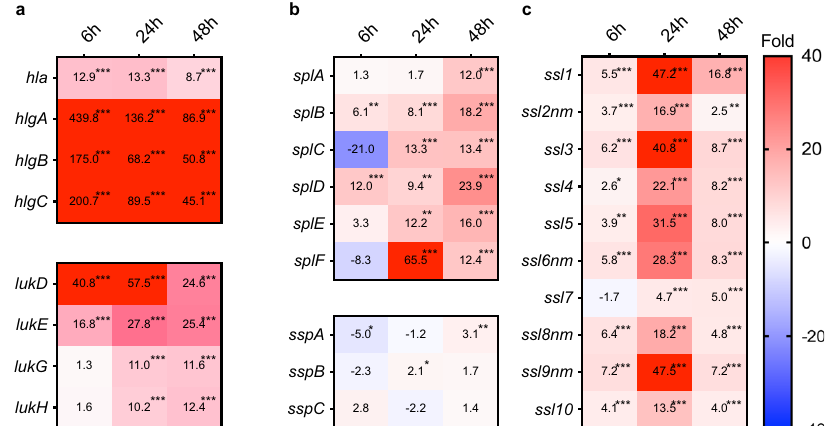
Fig. 5 Time course of expression changes in virulence factors in S. aureus -infected liver compared with culture medium. Time course of expression changes for toxins ( a ), proteases ( b ), and superantigens ( c ). Values in the boxes show fold-change compared with S. aureus cultured in the TSB medium and the boxes fi lled with red indicate >40-fold change. The asterisk *. **, and *** indicate FDR p -values < 0.05, <0.01, and <0.001, respectively. lukG and lukH genes in ( a ) are annotated as lukS and lukF in Refseq (NZ_CP023390.1), although we annotated these as lukGH genes as these genes are not related to the PVL phage and are similar to the lukGH